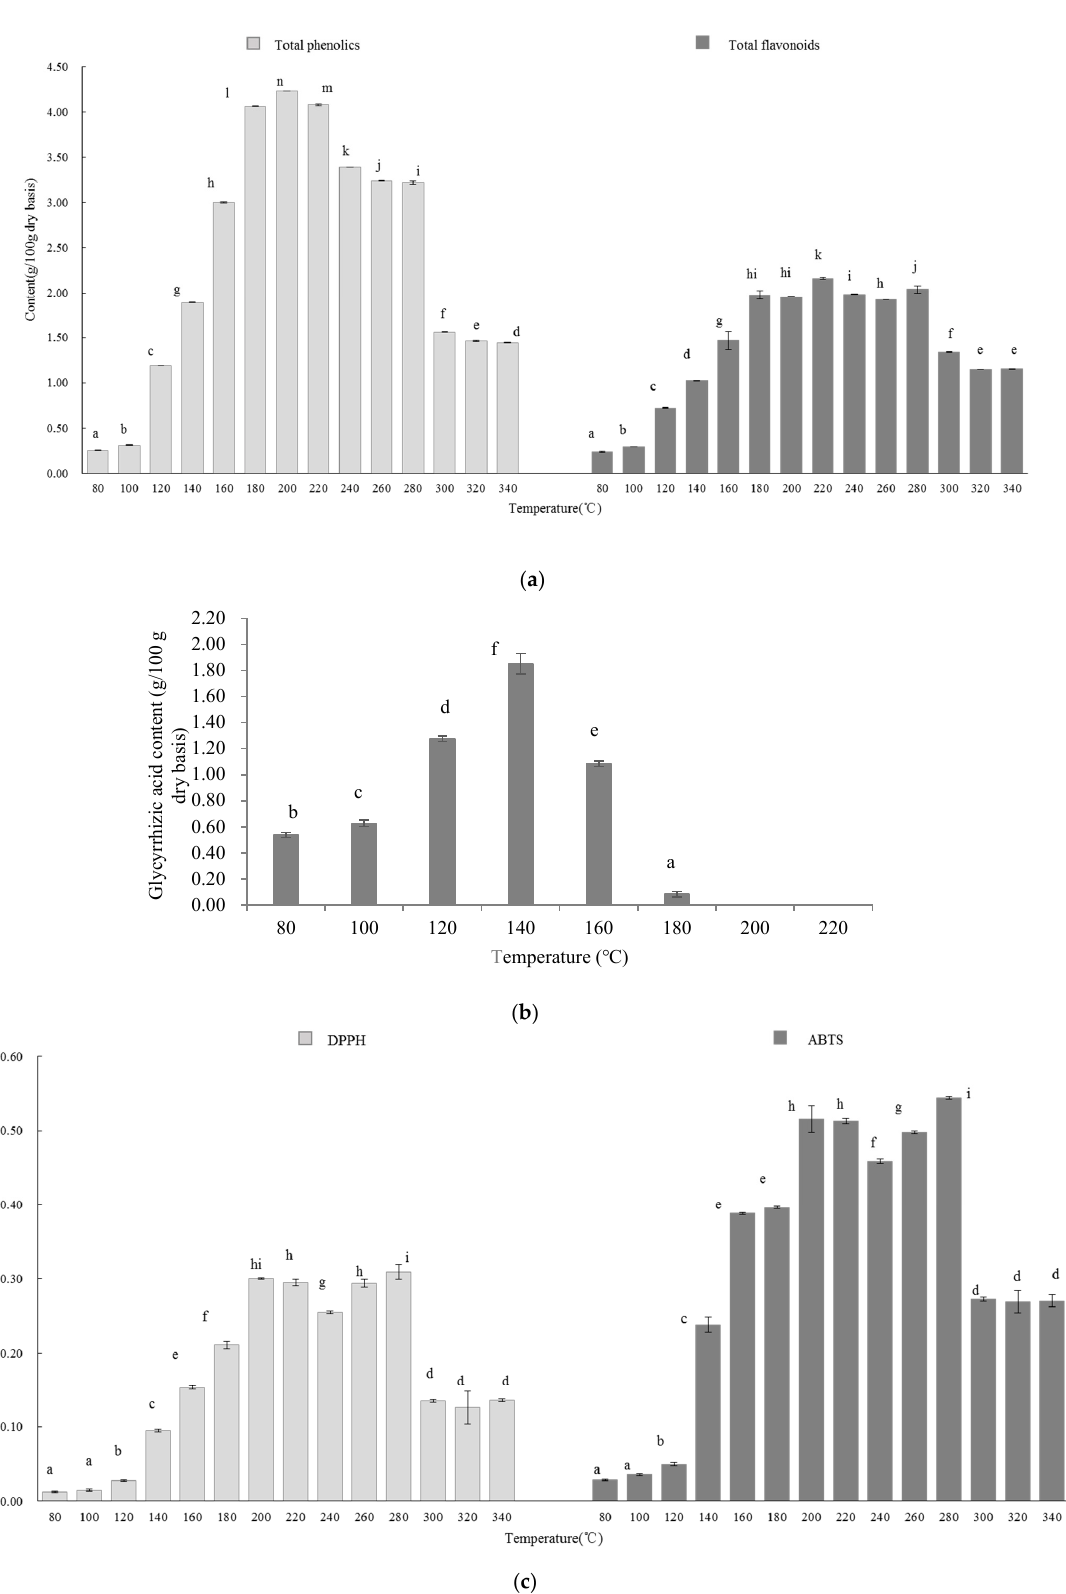
Figure 2. The effect of extraction temperature on the content of total flavonoids, total phenolics ( a ) and glycyrrhizic acid ( b ) and the effect of extraction temperature on total antioxidant activity ( c ). The results are expressed as the mean ± standard deviation ( n = 3); different letters indicate significant differences ( p < 0.05) and the same letters indicate insignificant differences.